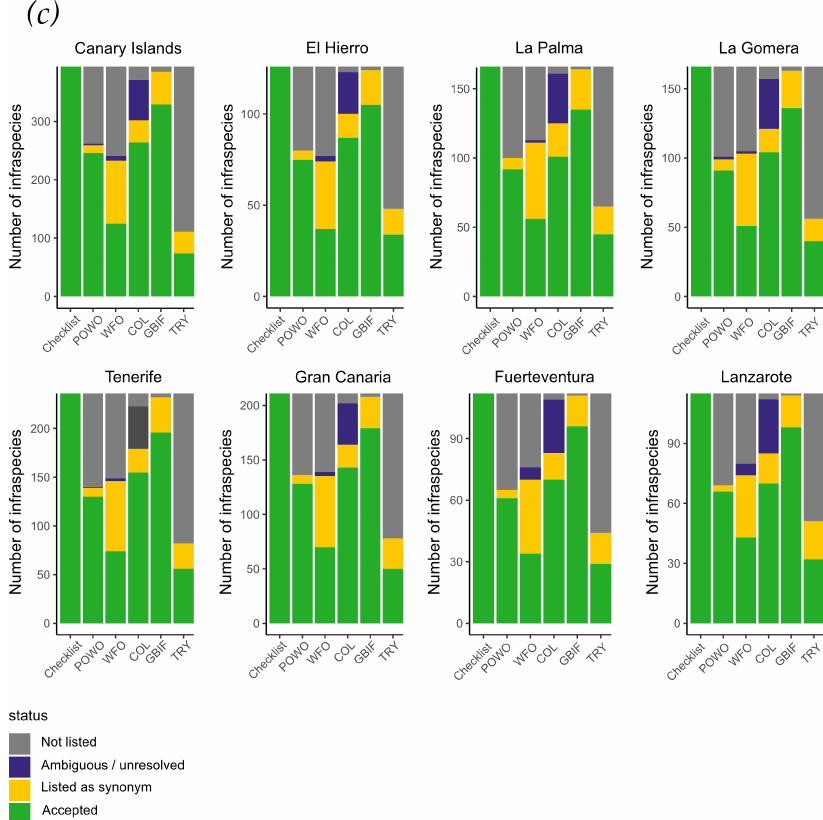
Figure 4. Representation of the accepted taxa suggested in this checklist for the Canary Islands in global databases. ( a ) for all taxa, ( b ) for species, and ( c ) for infraspecific taxa (subspecies and varieties). Note that scales for ( a , b ) do not begin with 0 taxa/species but start at 50% of each individual y-axis to work out differences. Axis ( c ) for infraspecific taxa start in 0. Numbers of accepted taxa diverge between POWO and WFO, reflecting that POWO was taken as a reference. COL numbers are close to those of POWO, which supports the decision to select this database for reference. The patterns for individual islands resemble the pattern of the entire